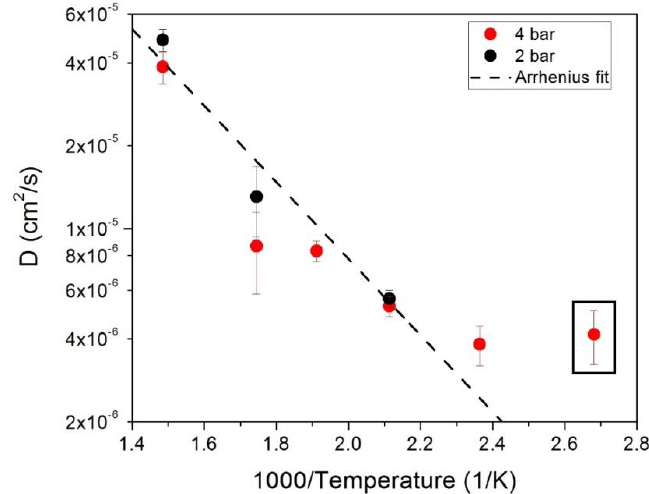
Figure 5. Calculated di ff usion coe ffi cients plotted against the inverse temperature in an Arrhenius plot. The line is a fit through all data points except the lowest temperature one (included in a black